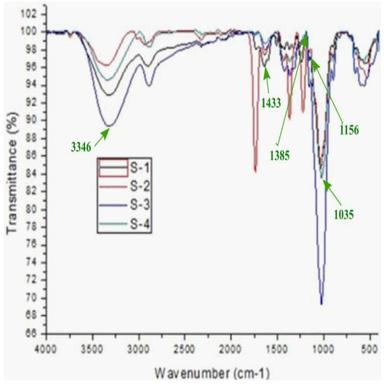
FTIR spectra of of bamboo fibers: (a) untreated BF (S-1), (b) alkali treated BF (S-2), (c) acid alkali treated BF (S-3) and (d) nanocellulose (S-4).